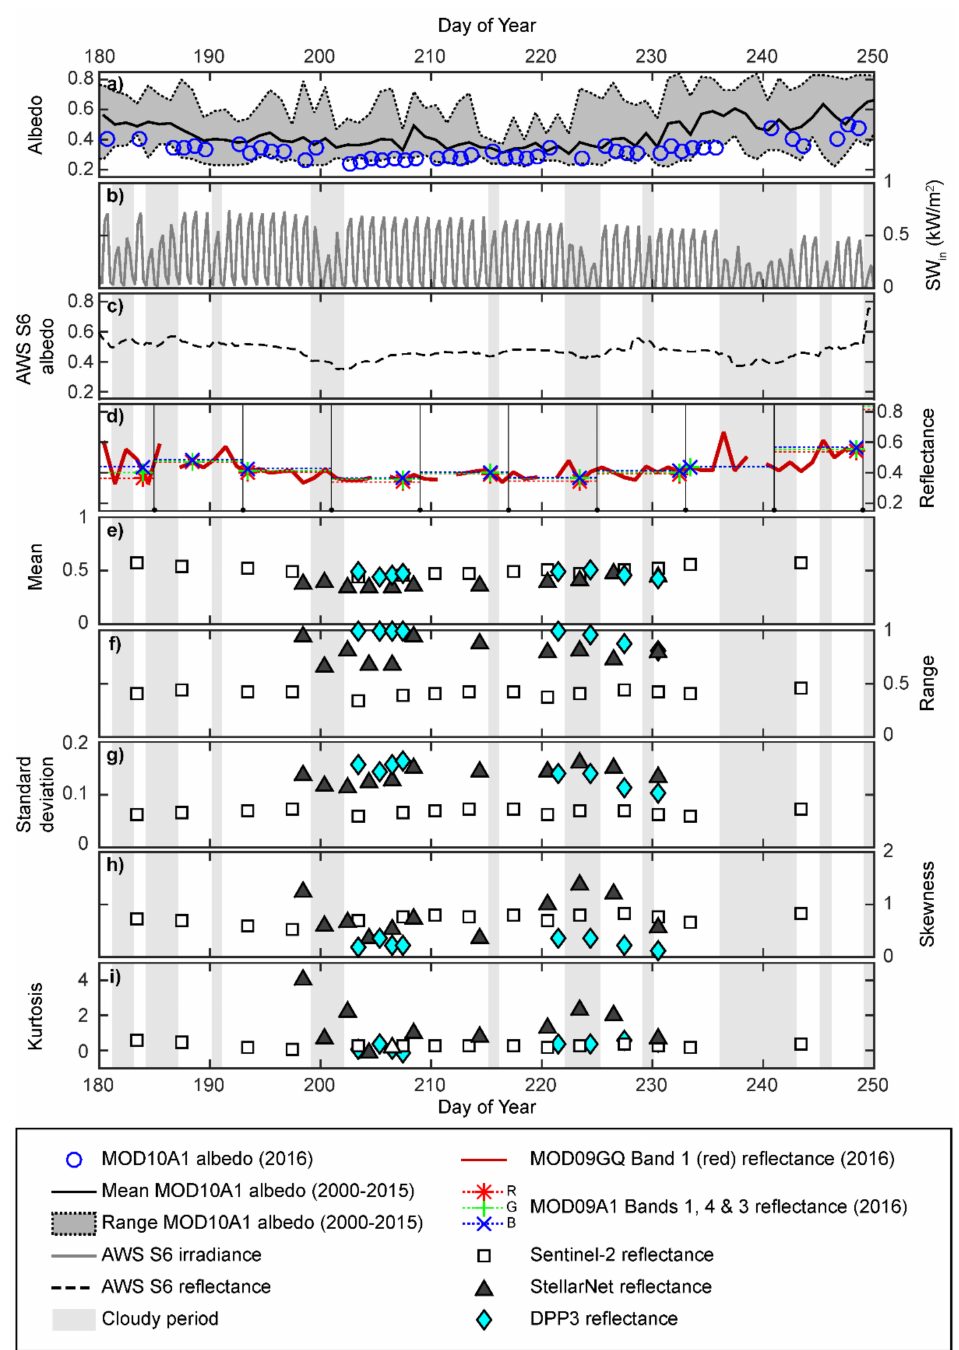
Figure 2. ( a ) Filtered MODIS MOD10A1 albedo series for 2016 shown in comparison with the records for 2000–2015 for the single pixel co-located with this study’s ROI. ( b ) Irradiance at the S6 automatic weather station, used to indicate cloud influenced time periods during 2016. ( c ) Ice surface reflectance (or accumulated albedo) derived from the S6 weather station during 2016. ( d ) Quality filtered MODIS MOD09GQ time-series, for 2016, with the MOD09A1 8-day composite product windows indicated for the latter. Summary statistics including ( e ) spatial means, ( f ) maximum ranges, ( g ) standard deviations, σ , ( h ) skewness, s, and ( i ) kurtosis, k, for the Sentinel-2, StellarNet (SNBW) spectrometer and UAV (DPP3) derived reflectance